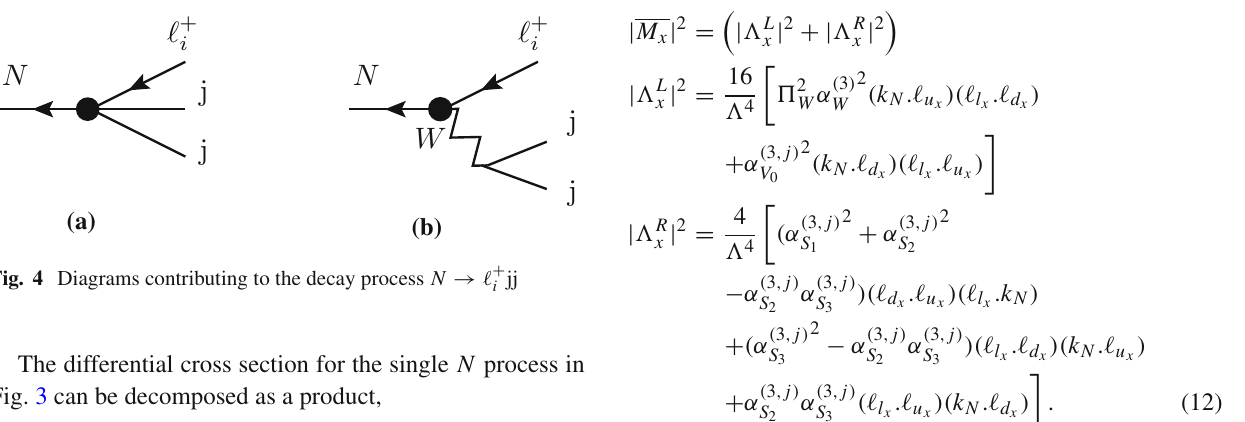
the N : k 1 , k 2 , k 3 for x = I I , I I I , V , as indicated in Figs. 1 and 3, and the index j = 1 , 2 corresponds to the final quarks family. The W boson propagator is (cid:14) W = (cid:6)